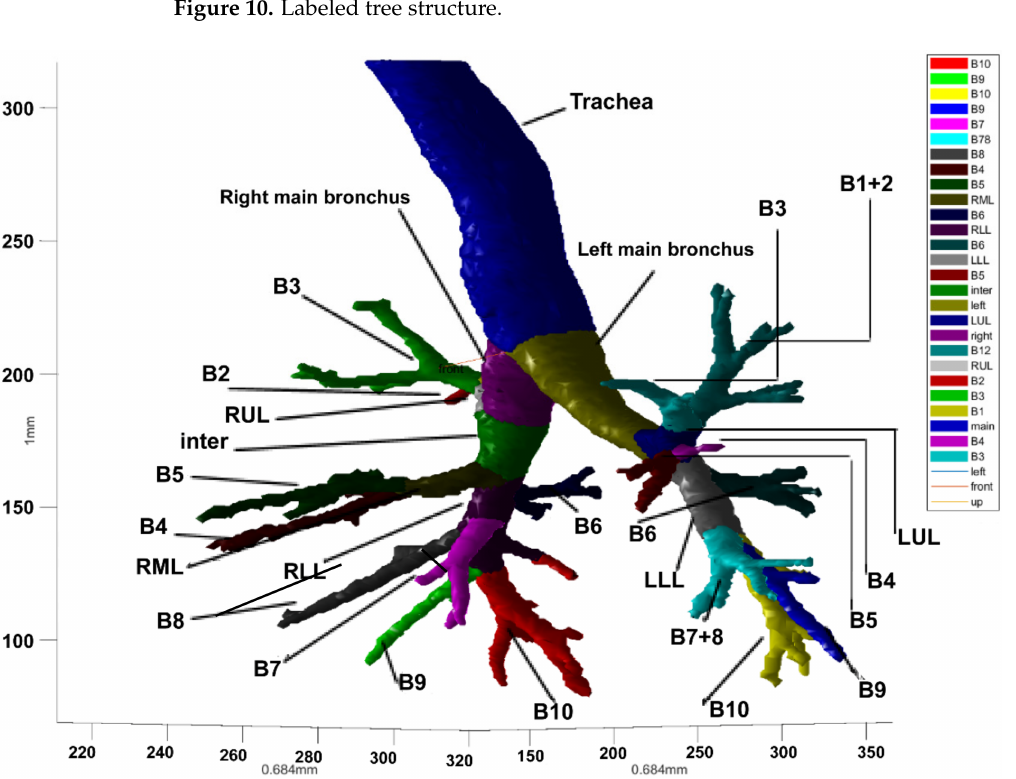
Figure 11. Labeled pulmonary airways (45